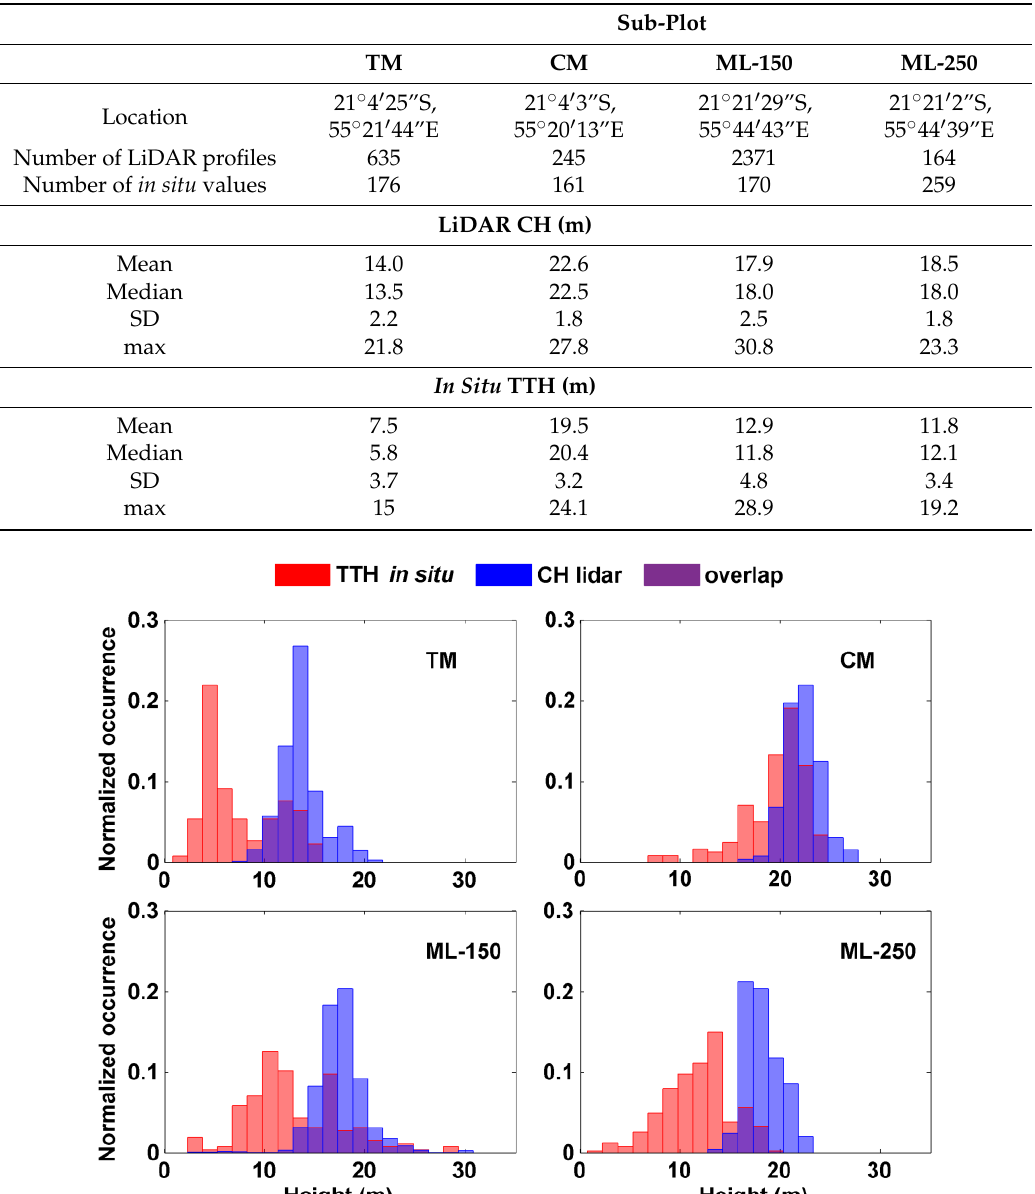
Figure 7. Distributions of the tree top height (TTH) from in situ (red) and canopy height (CH) from LiDAR (blue) measurements for the sub-plots of Tamarind site (TM), the Cryptomeria site (CM) and Mare-Longue tropical rain forest sites at 150 m (ML-150) and 250 m (ML-250) amsl. The overlapping parts are in purple. Uncertainty on retrieved heights is 4 m (2 m) for in situ (LiDAR) measurements.